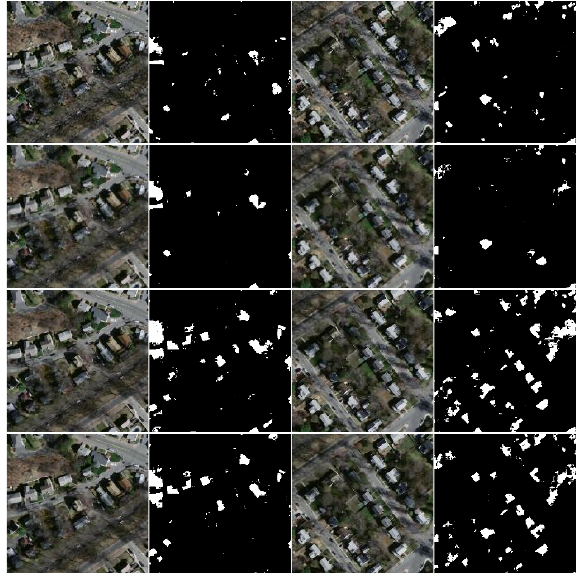
Fig. 1. Examples of the extraction results using “HRNet v2”